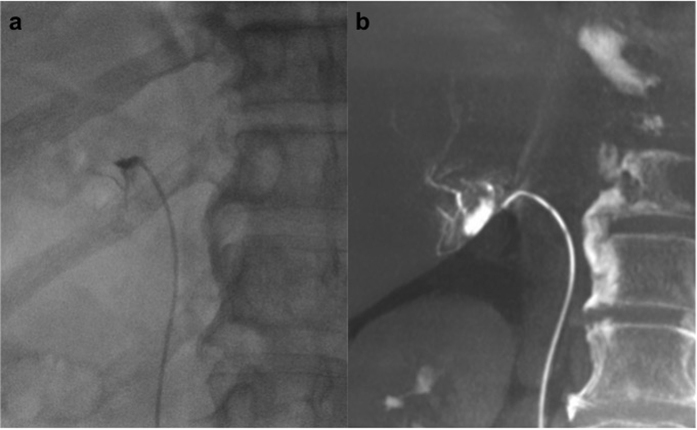
A 61-year-old man with primary aldosteronism (PA) and a right adrenal nodule.(a) The venogram pattern of the accessory hepatic vein was similar to that of the right adrenal vein. (b) Dyna computed tomography exhibited focal opacification of the liver parenchyma, with venous drainage into the accessory hepatic vein.